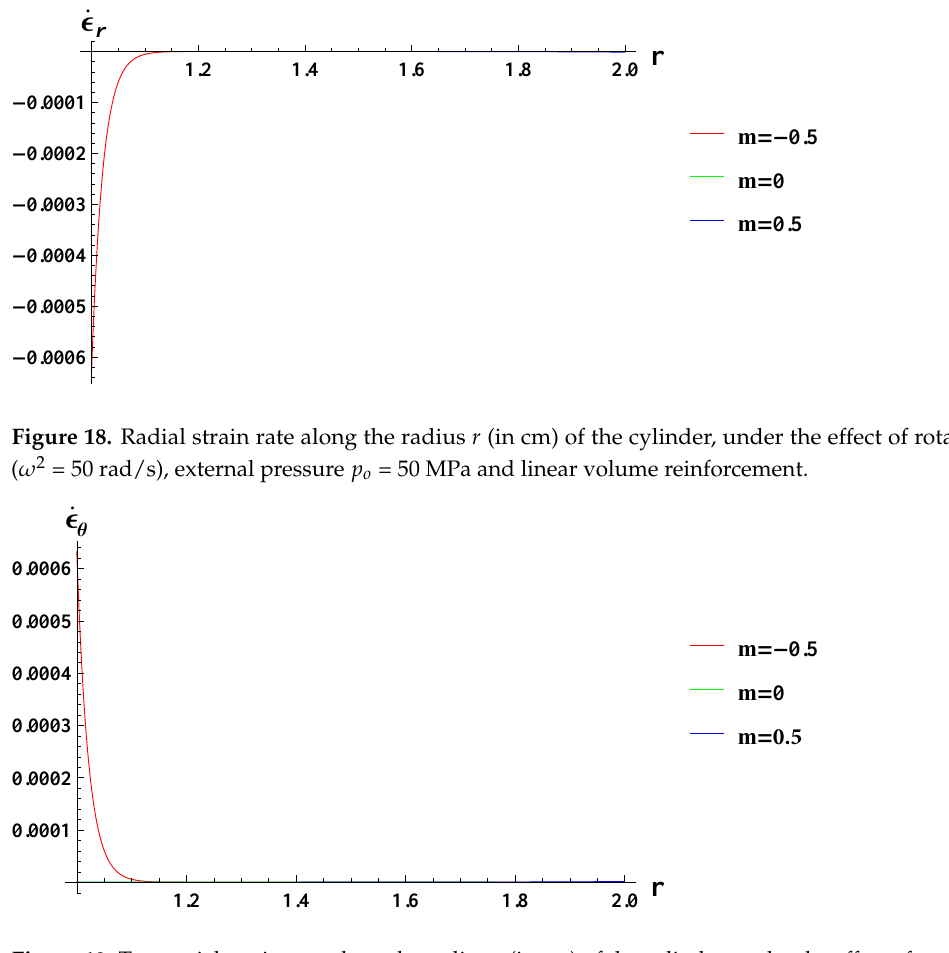
Figure 19. Tangential strain rate along the radius r (in cm) of the cylinder, under the effect of rotation ( ω 2 = 50 rad/s), external pressure p o = 50 MPa and linear volume